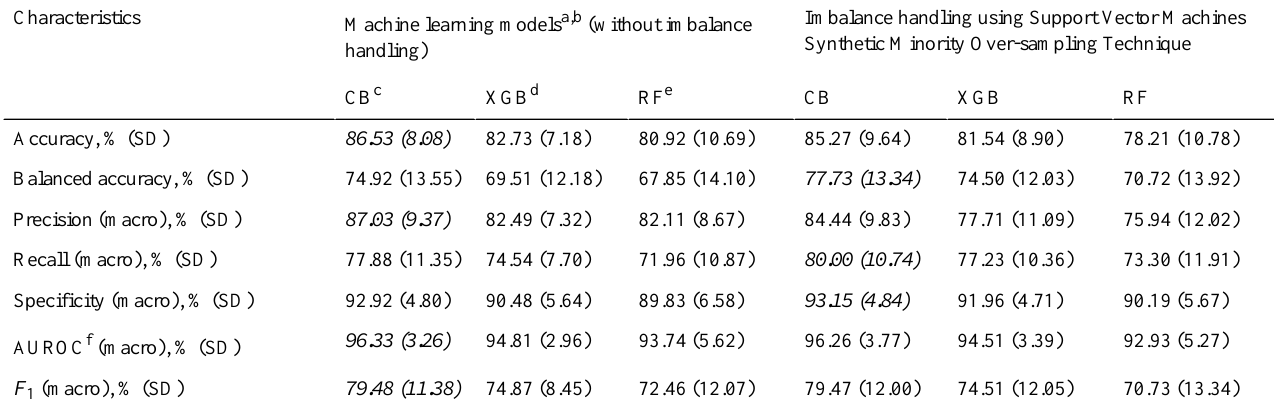
Table 5. Results of the personalized models for emotional state detection on the basis of a five-fold, stratified cross-validation.